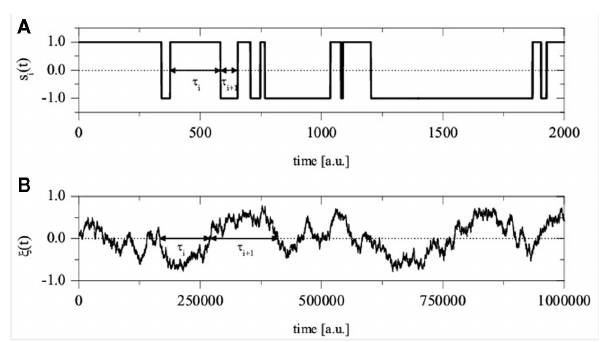
FIGURE 2 | (A) Temporal evolution of a single unit and (B) of the global order parameter for the DMM realized on a square lattice with L = 50, g 0 = 0.01, and K = 1.70. Notice the different time scales on the two plots. (FromTuralska et al., 2011, with